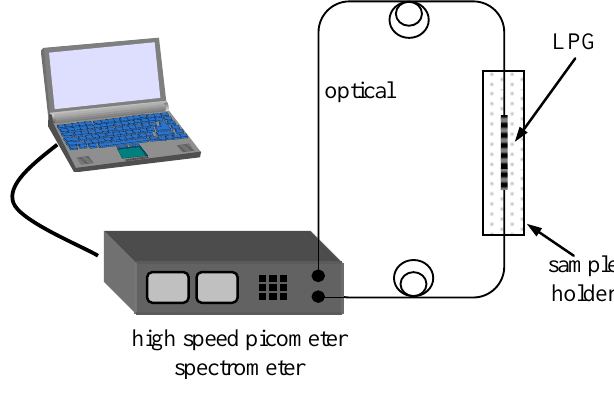
Figure 1. Experimental setup for testing LPFG biosensors for F. tularensis . The transmission spectrum was monitored by a high speed picometer spectrometer (Micron Optics SI720; measurement range 1,520–1,570 nm; wavelength resolution 0.25 pm; wavelength accuracy ±1 pm) and recorded by a